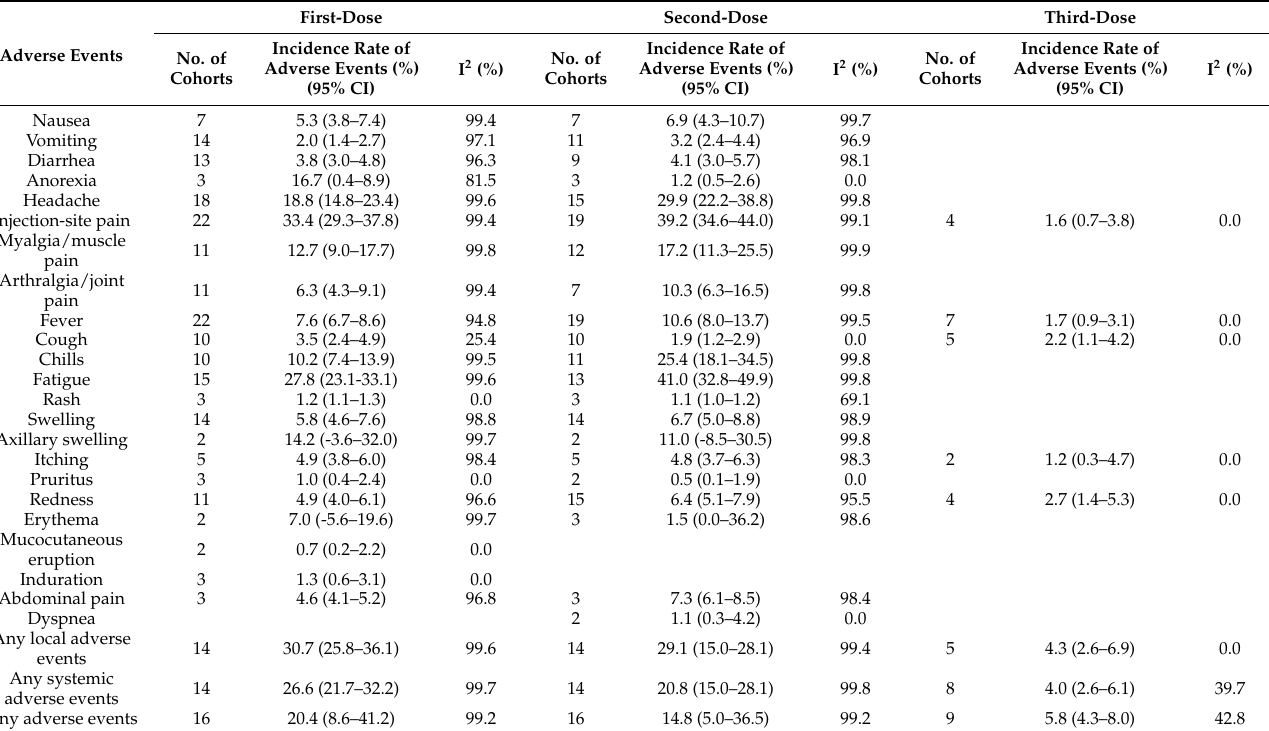
Table 2. Incidence rates of adverse events after each dose of SARS-CoV-2